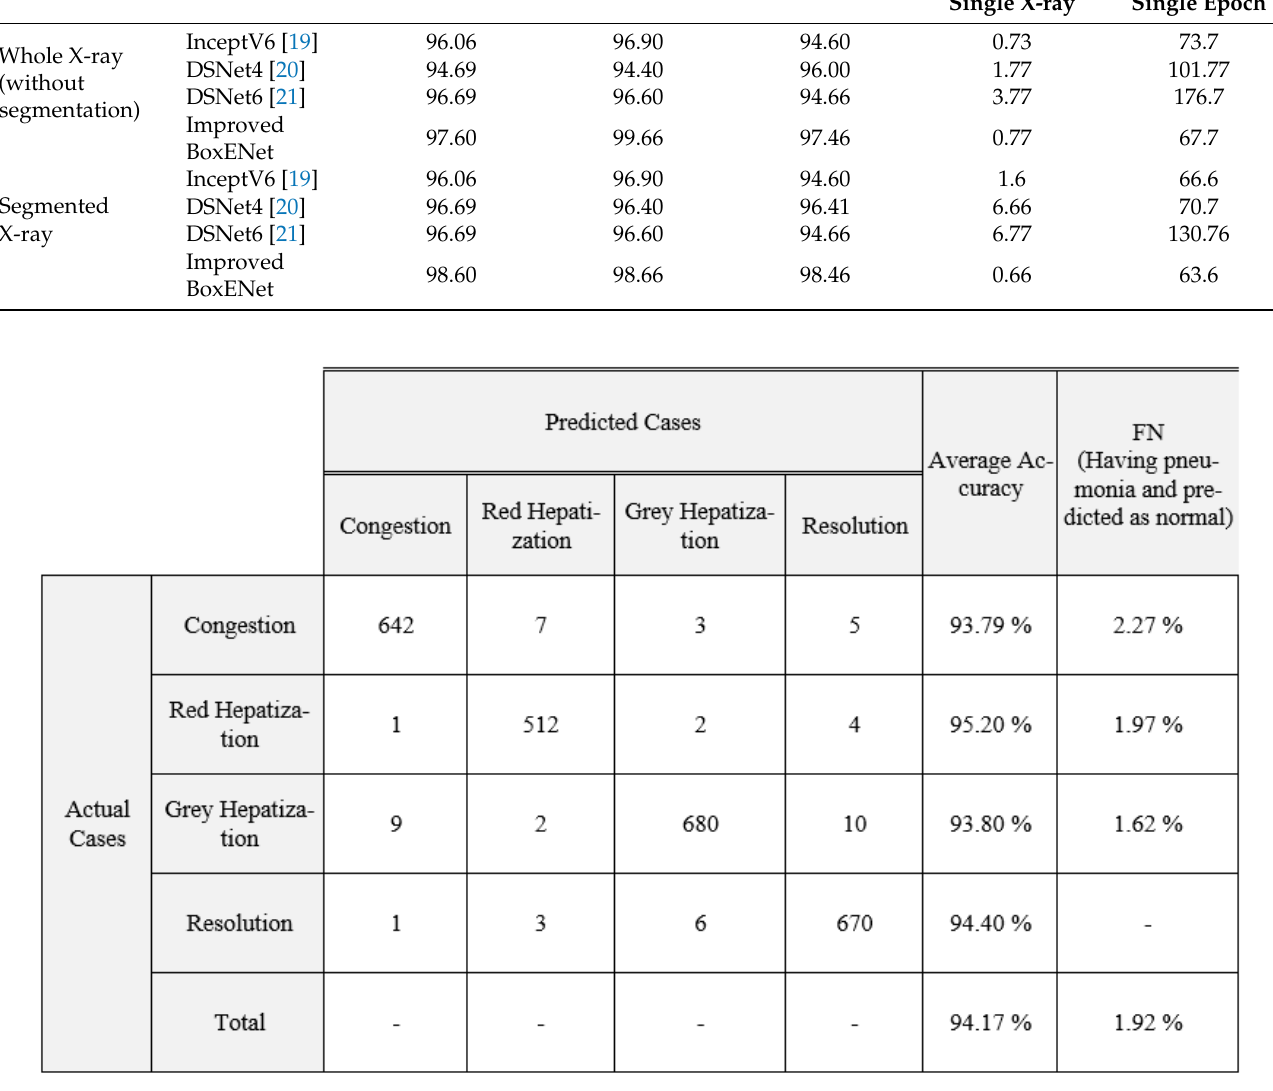
Figure 6. Confusion matrix for multi-classification for the improved BoxENet model without seg- mented X-ray.